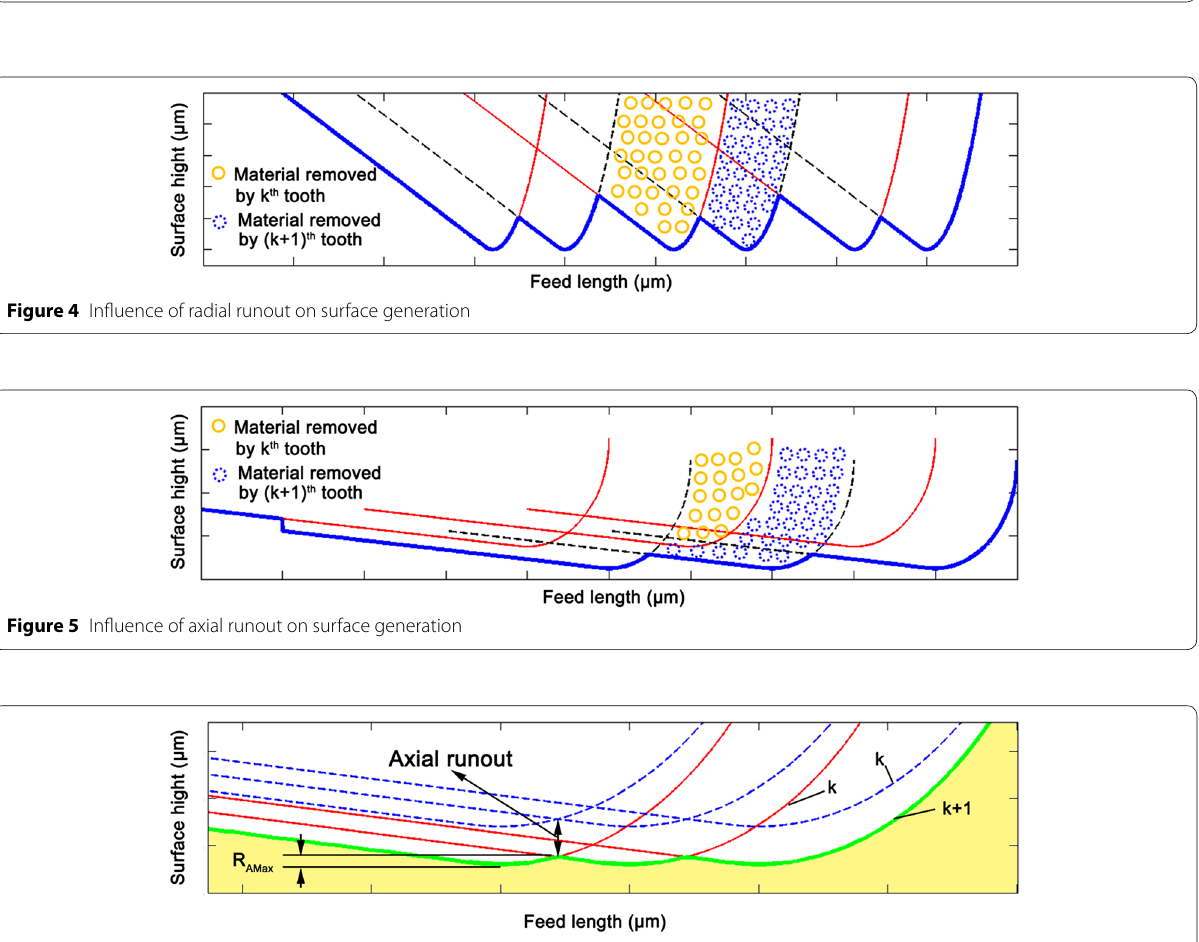
Figure 6 First case of the surface profile considering radial and axial